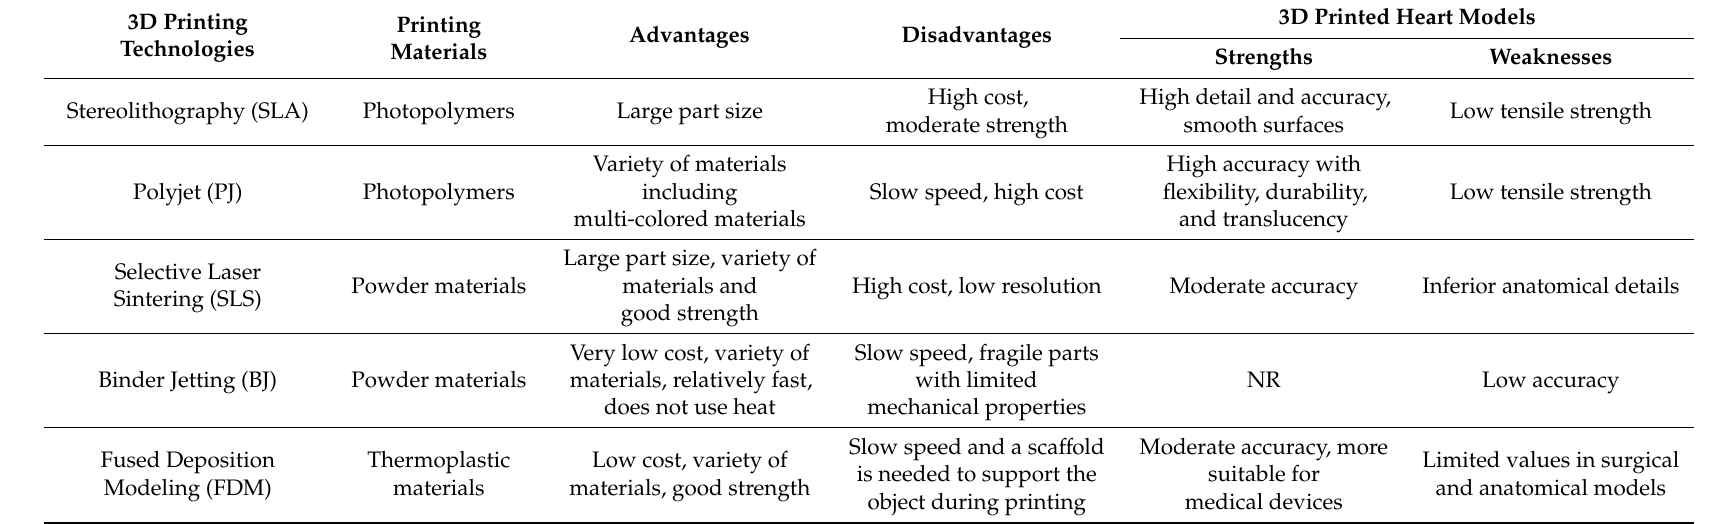
Table 3. Summary of di ff erent types of 3D printing technologies and corresponding 3D printed heart models. Adapted from References